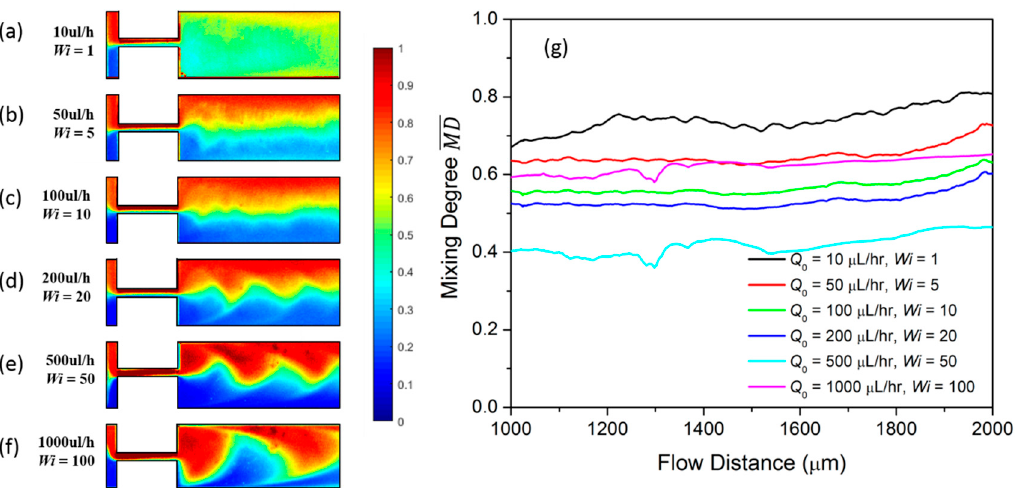
Figure 5. Concentration profile of viscoelastic fluid at di ff erent constant flow rates of ( a ) Q 0 = 10 µ L / h; ( b ) Q 0 = 50 µ L / h; ( c ) Q 0 = 100 µ L / h; ( d ) Q 0 = 200 µ L / h; ( e ) Q 0 = 500 µ L / h and ( f ) Q 0 = 1000 µ L / h; ( g ) the averaged mixing degree MD of viscoelastic fluid at di ff erent constant flow rates mixing.